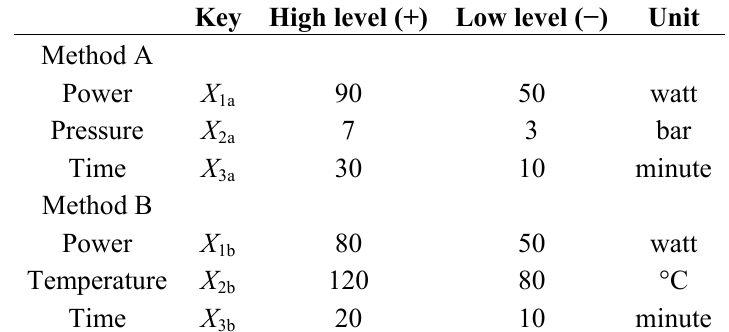
Table 1. Factor levels in the Plackett–Burman design for MAOS AS101 synthesis.